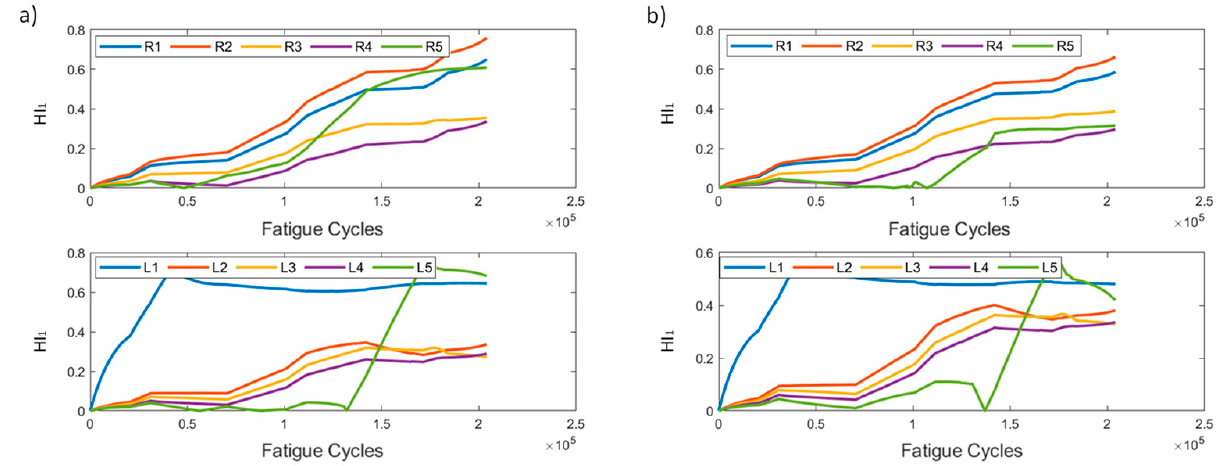
Figure 14. HI 1 progression through time for the two pre-processing methods for specimen VA-1: ( a ) method 1, ( b ) method 2.